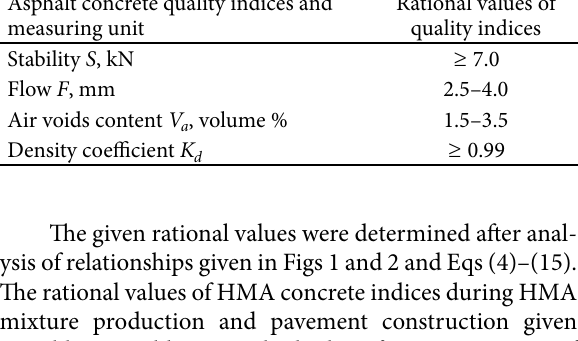
Table 1. Rational values of the quality indices of the top layer of motor road HMA pavement Asphalt concrete quality indices and measuring